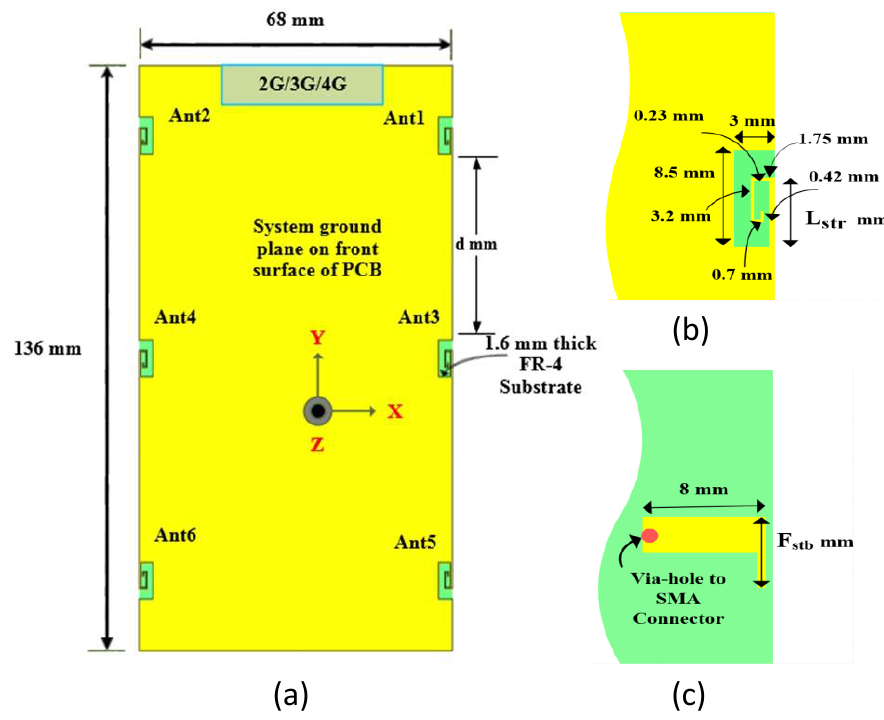
Figure 1. ( a ) The multiple antenna system for multiple-input multiple-output (MIMO) application in a smartphone. ( b ) Geometric configuration of unit slot antenna. ( c ) Inverted-L feeding